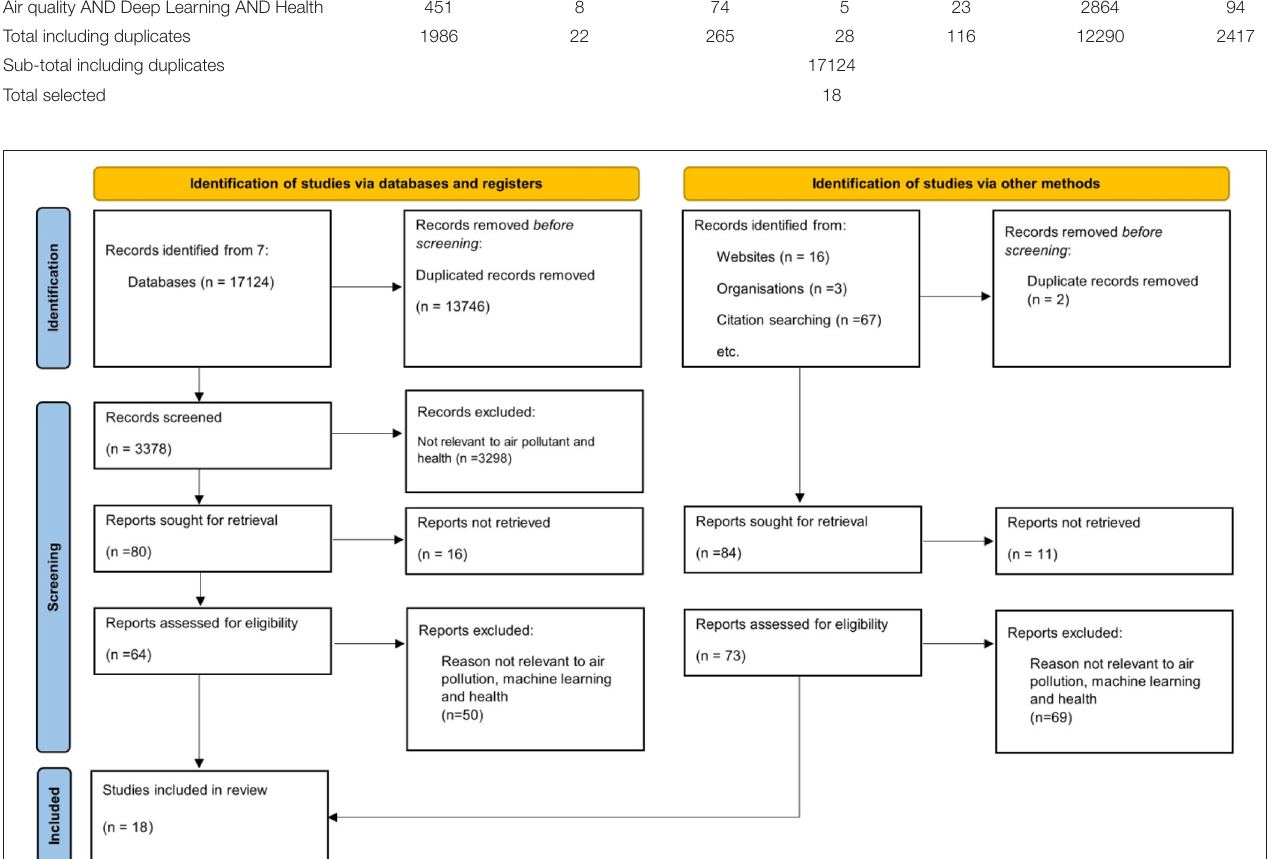
FIGURE 1 | PRISMA flow chart of the review adopted from the PRISMA 2020 statement: an updated guideline for reporting systematic reviews